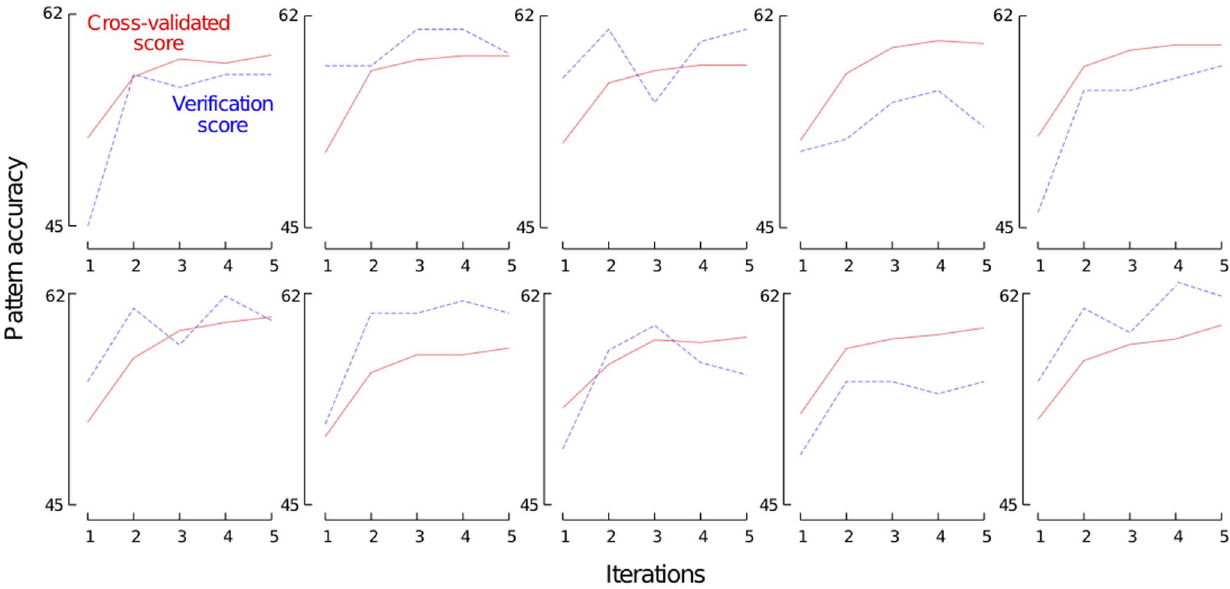
Figure 5. Forward feature function selection with 10 train/test splits of the SPX z dataset. Each figure reports the results of five iterations of our forward feature function selection algorithm on one of ten train/test splits. Solid red lines are the cross-validated scores and dashed blue lines are the verification scores.